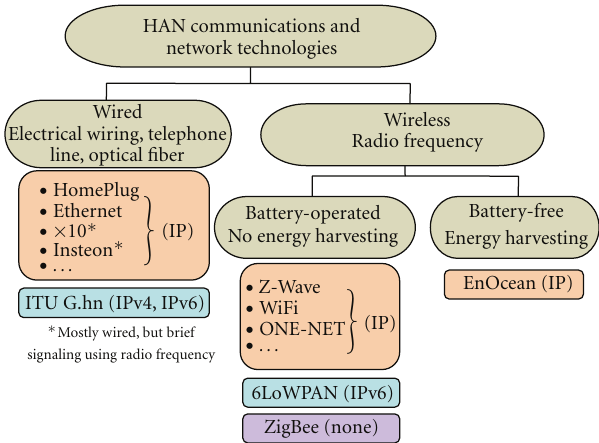
Figure 4: Communications and networking possibilities for a home area